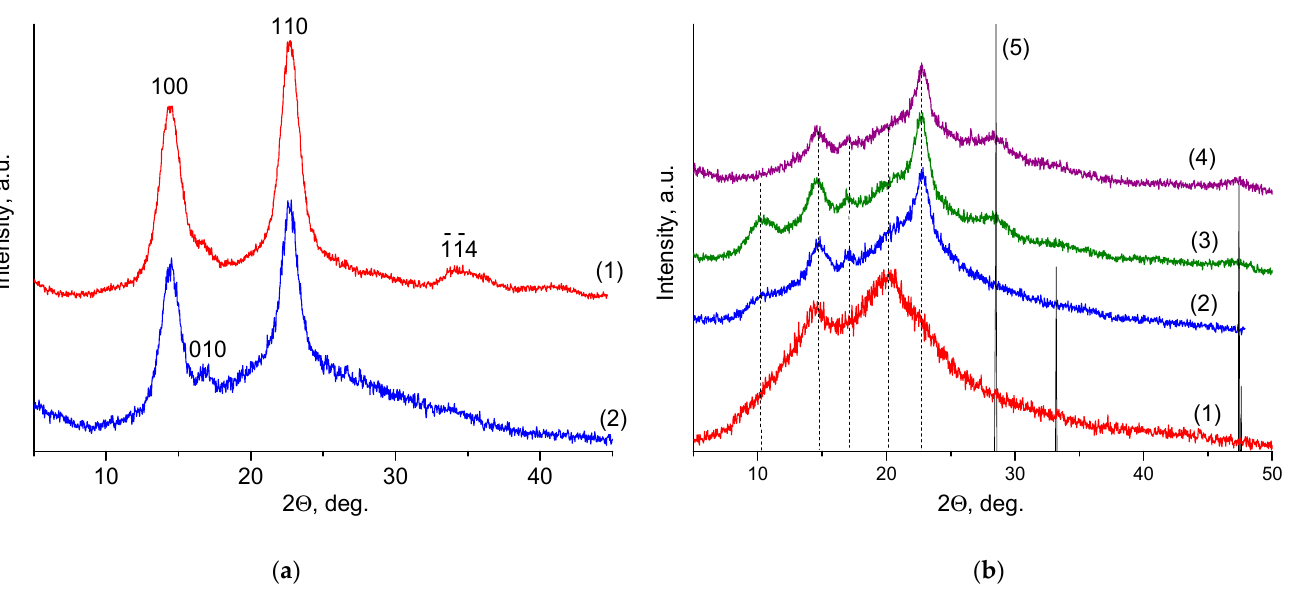
Figure 3. Wide-angle X-ray scattering patterns of: ( a ) BC (1), BCd (2); ( b ) CS (1), CS(80)-BCd(20) (2), CS(80)-BCd(20)-CeONP(4) (3), Cs(80)-BCd(20)-CeONP(8) (4), CeO 2 ICDD PDF card #34-394 (5). The diffractogram of CS(80)-BCd(20)-CeONP(4) (Figure 3b(3)) shows a more intense reflex in the 10 ◦ region compared to the control, corresponding to the hydrated polymorphic modification of CS. Increasing the CeONP content in CS(80)-BCd(20)-CeONP(8) (Figure 3b(4)) leads to the disappearance of this reflex (anhydrous CS polymorphic modification).